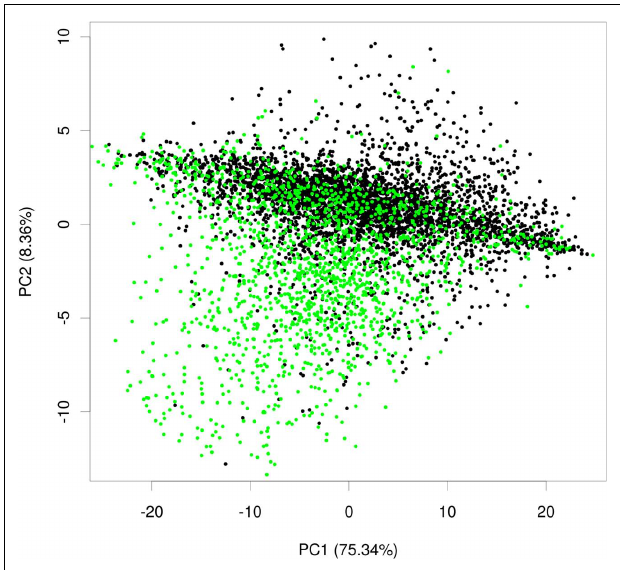
FIGURE 2 | Principle component analysis plot of plastid and non-plastid proteins. Exemplary principal component plot showing plastid proteins in green and proteins from other compartments in